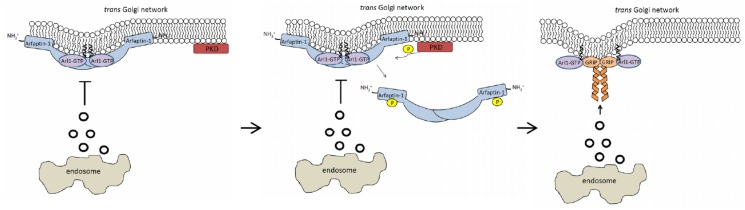
Schematic of the proposed role of arfaptin-1 in Arl1-mediated retrograde transport.Arfaptin-1 is recruited to the TGN through interaction with GTP-bound Arl1, where it inhibits vesicle transport from endosomes to the Golgi. Arfaptin-1 disassociates from GTP-bound Arl1 until protein kinase D phosphorylates arfaptin-1 at the N-terminus. The GTP-bound Arl1 then recruits GRIP domain-containing proteins to the TGN and receives the cargo proteins transported from the endosomes to the Golgi.